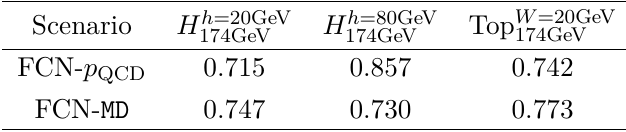
Table 6 . OoD test AUCs for a Fully Connected